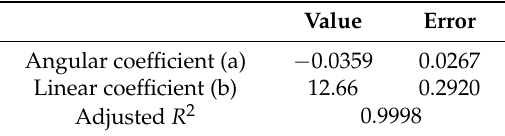
Table 1. Values corresponding to the equation generated for calculating the concentration of citronella essential oil at 333 nm.